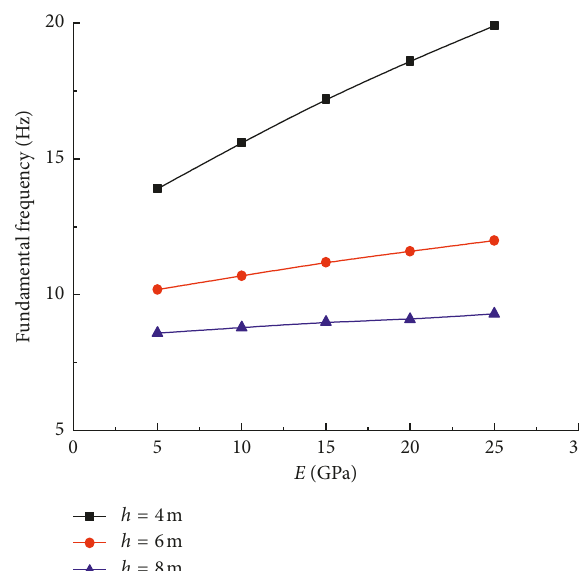
Figure 6: Effects of wall modulus on fundamental frequencies.